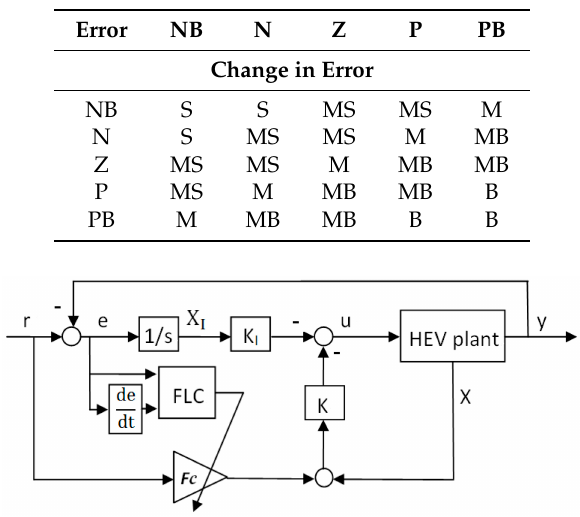
Table 2. The rule base of the FLC: positive big (PB), positive (P), zero (Z), negative (N), negative big